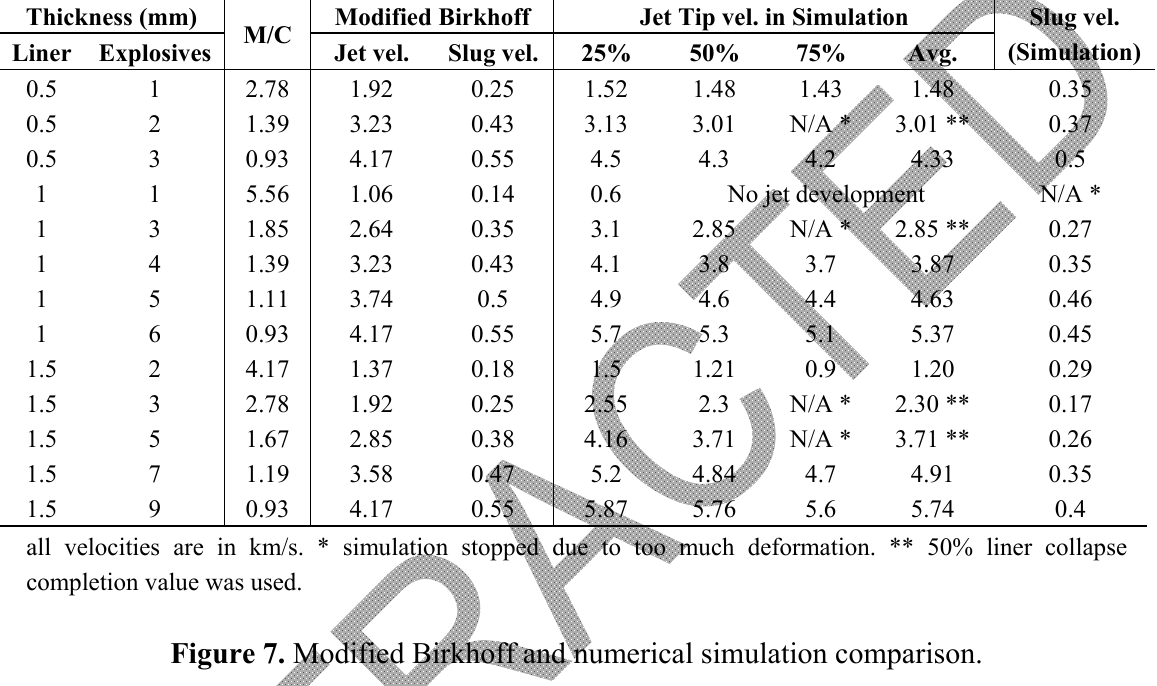
Figure 7. Modified Birkhoff and numerical simulation